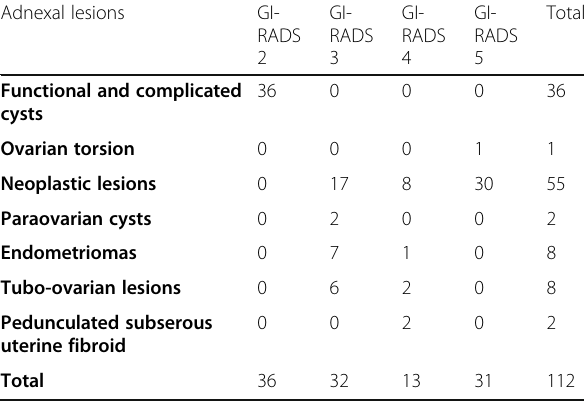
Table 3 Distribution of the adnexal lesions by GI-RADS Adnexal lesions GI-